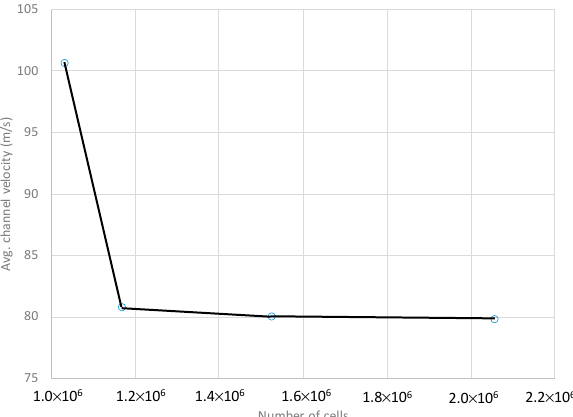
Figure 13. Mesh independence study showing absolute mass averaged velocity in the channel versus number of computational cells used.